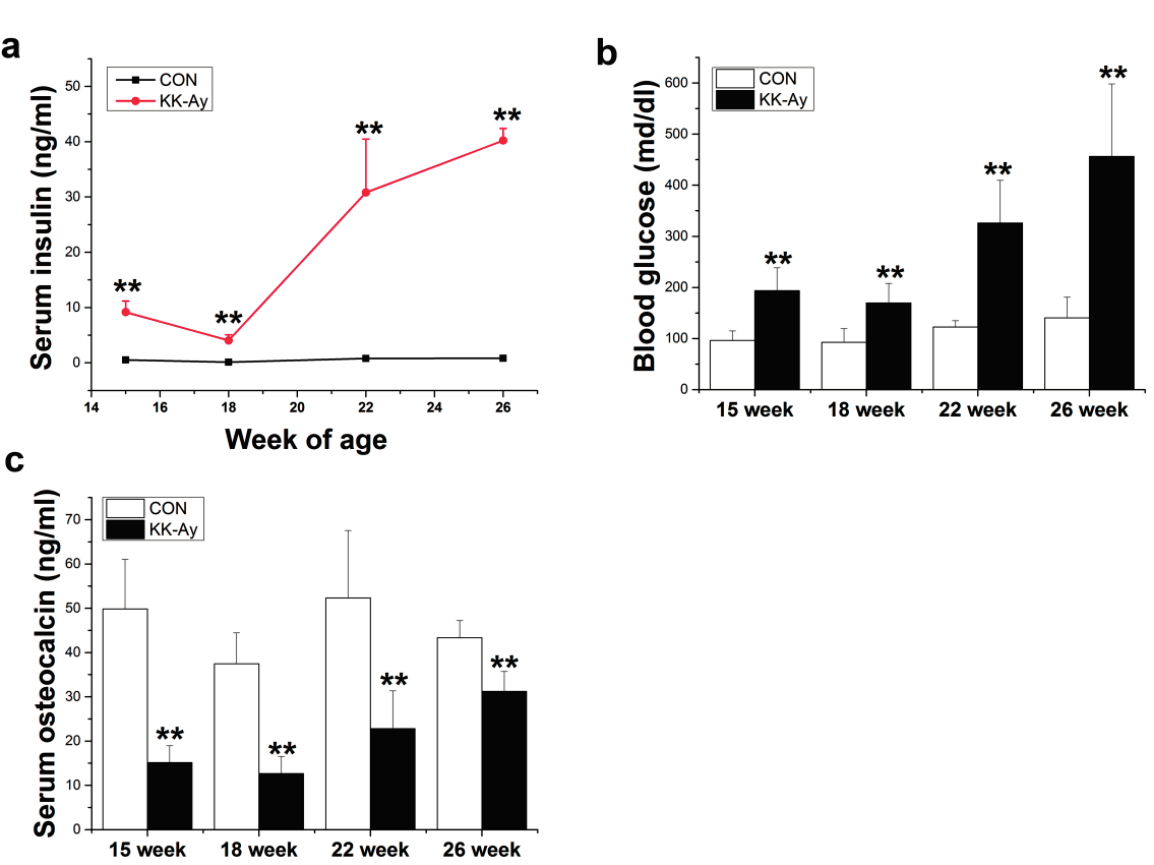
Figure 1. Serum biochemical parameters in control (CON)and KK-Ay mice ( a ) serum insulin; ( b ) fasting blood glucose; ( c ) serum osteocalcin, n = 10, ** p < 0.01 vs.